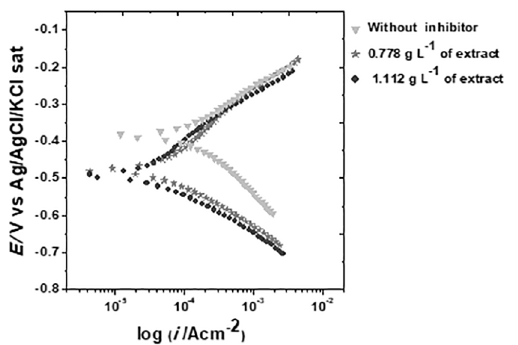
Figure 8. Potentiodynamic polarization curves for CS - ASTM 1020 after 120 min immersion in 18.23 g L -1 HCl solution in the absence and in the presence of different amounts of cocoa bark extract.